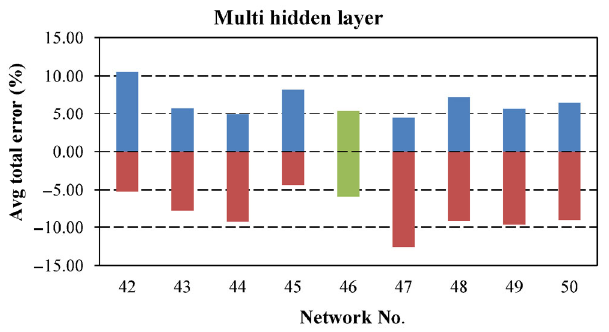
Average total error% for MHL-ANN architectures (Network Nos. 42 − 50).